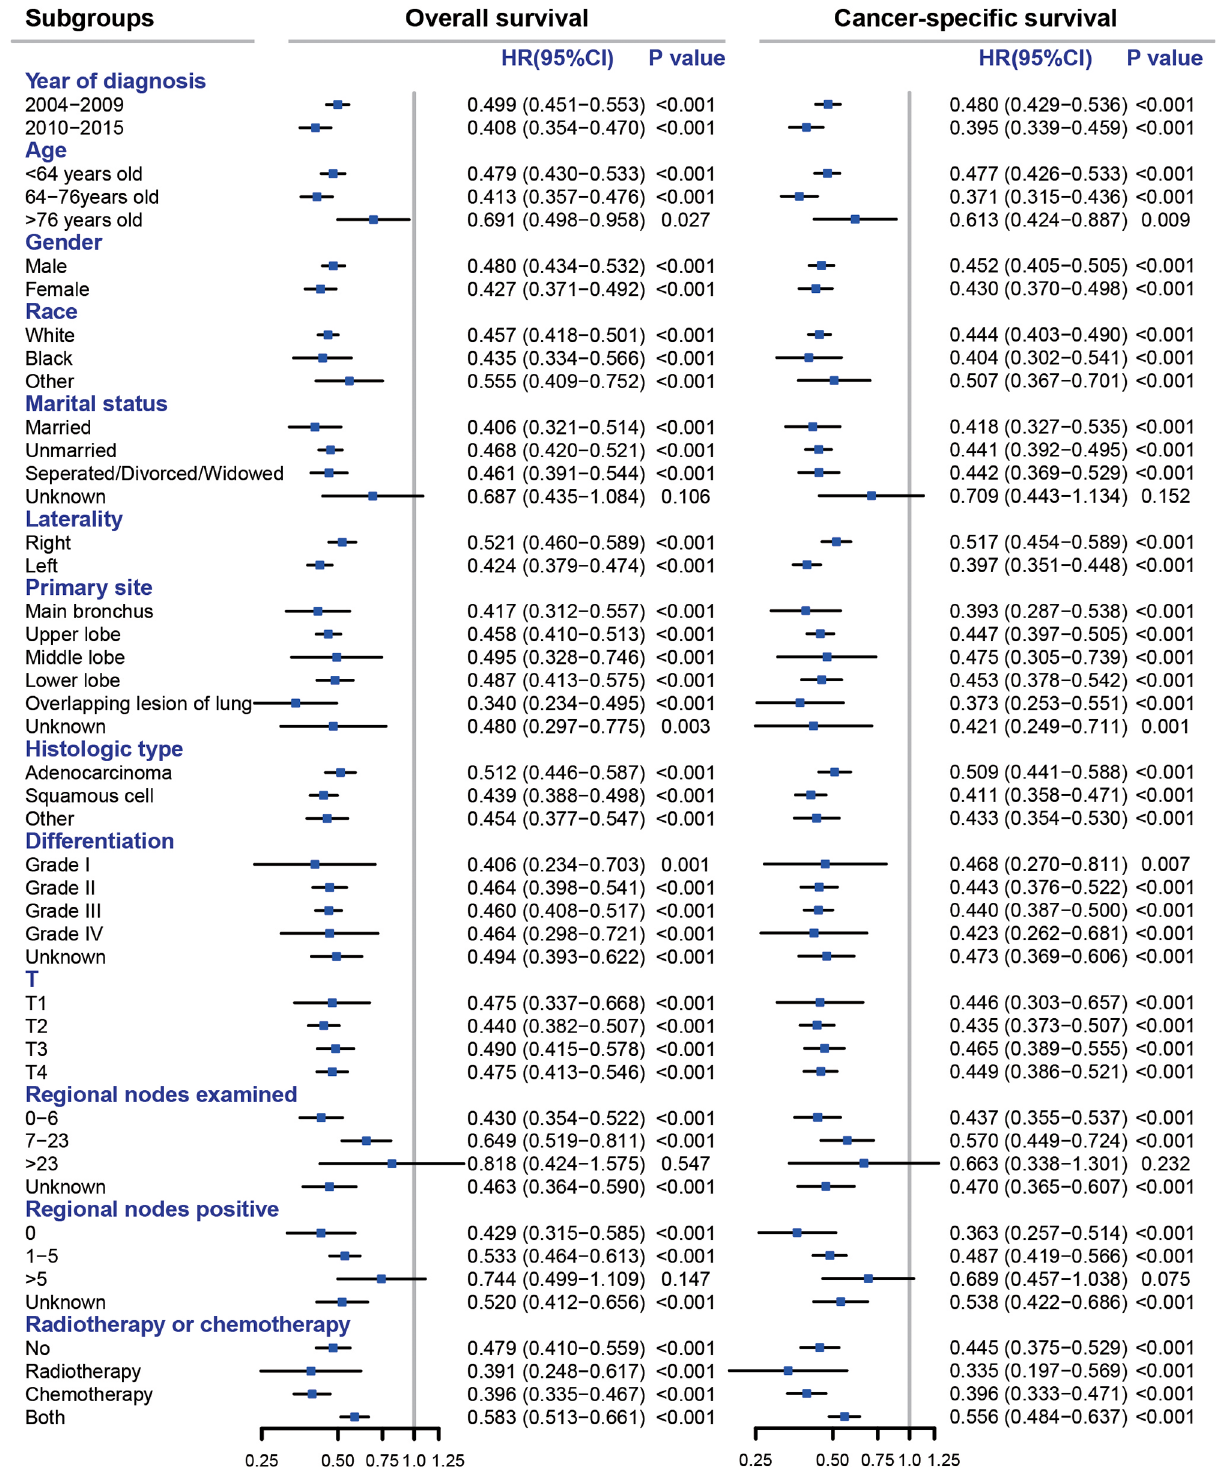
Frontiers in Oncology |